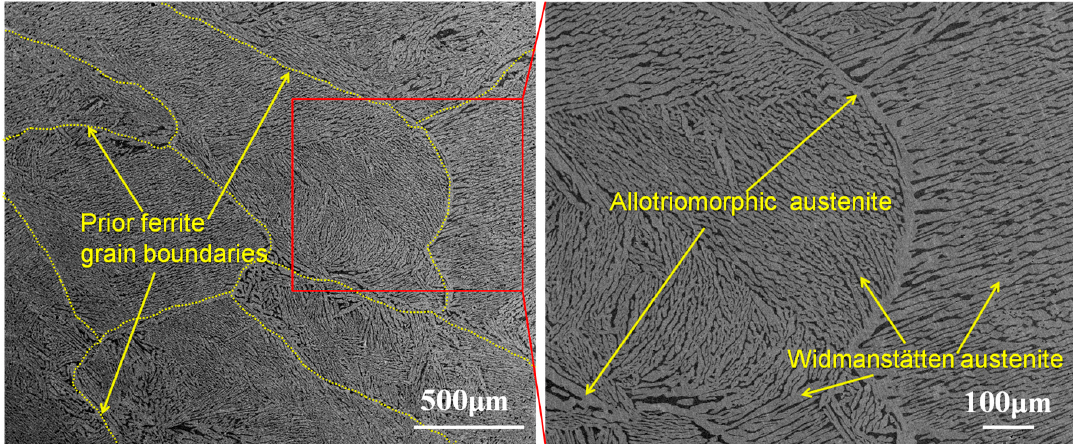
Figure 3. Equilibrium calculation of the Fe-21Cr-10Ni-0.35Si-xMo alloy at high temperature regions.